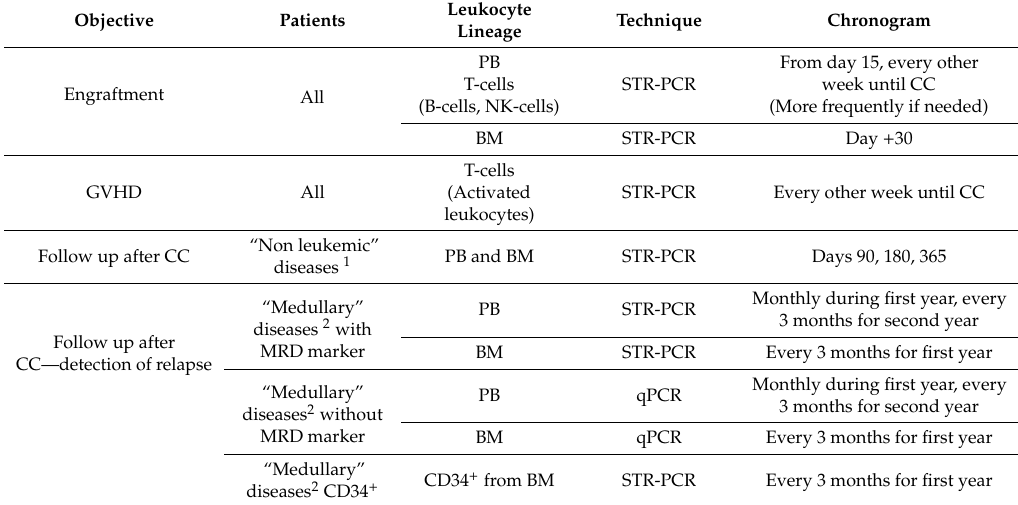
Table 4. Proposed algorithm for chimerism follow-up. 1 Lymphoma, Non-malignant diseases. 2 Hematological malignancies with medullary infiltration (i.e., Acute and Chronic Leukemia, Myelodisplastic Syndrome, Myeloproliferative Neoplasm). CC: complete chimerism. GVHD: Graft versus Host Disease. MRD: Minimal Residual Disease.